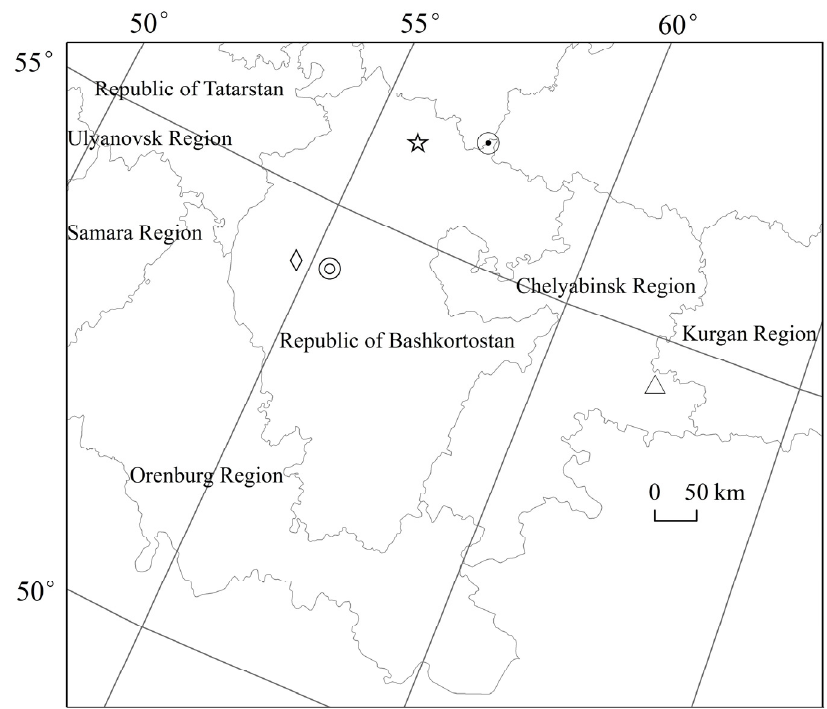
Figure 2. Spatial pattern of Russia’s geographical gravity center, population gravity center, and eco- nomic gravity center. Note: △ is Russia’s geographical gravity center. ⊙ is Russia’s economic gravity center in 2002. ☆ is Russia’s economic gravity center in 2020. ◎ is Russia’s population gravity center in 2002. ◇ is Russia’s population gravity center in 2020.